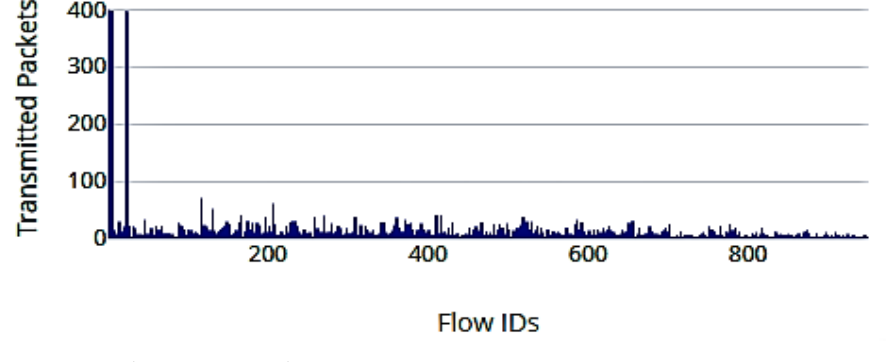
Figure 5. Packets transmitted.